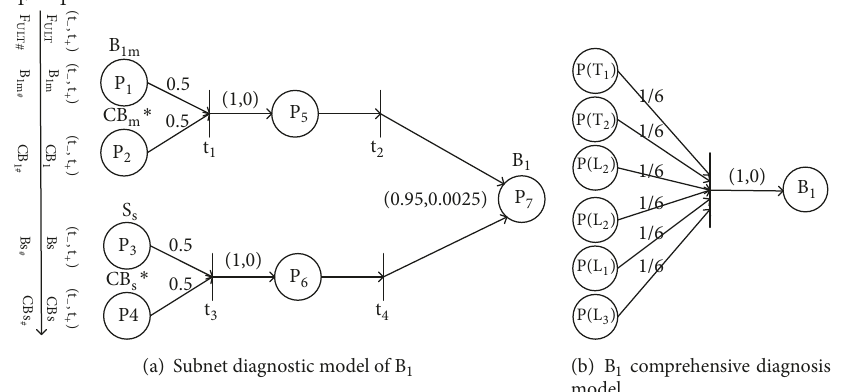
Figure 6: Double bus B 1 fault diagnosis